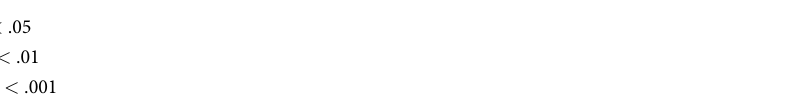
with depression and anxiety [27, 28, 29]. Moreover, the findings of the present study show that the high school students had more-addictive tendencies towards SD use than the secondary school students did. This could be due to the fact that high school students have more friend- ships and more spare time, so they try to stay connected with others through social media or